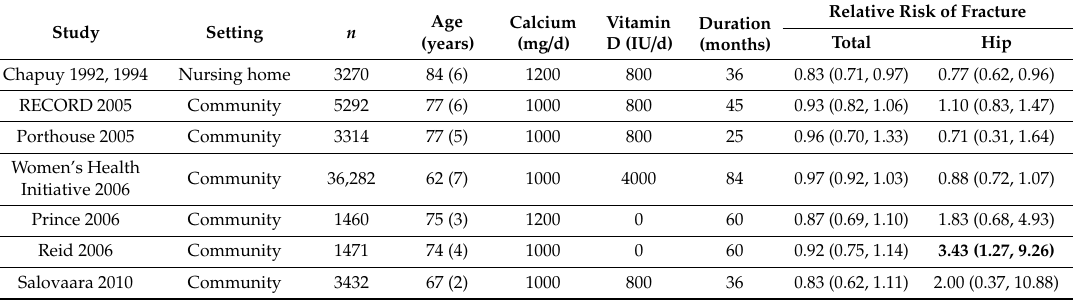
Table 1. Major trials of calcium ± vitamin D on fracture.